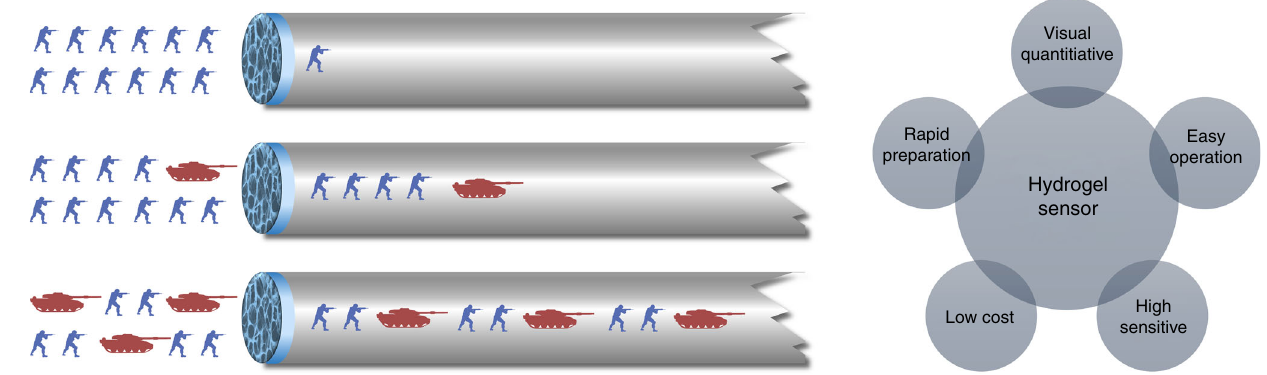
Fig. 1 The scheme of a target-responsive hydrogel fi lm in capillary tube for visual quantitative detection. The soldiers in the picture represent the solvent molecules that can slowly permeate through the gel membrane, and the tanks in the picture represent the target molecules that can degrade the gel membrane. In the presence of cocaine, cocaine molecules can change the internal structure of DNA hydrogel, resulting in an increase in the permeability of the fi lm and the fl ow rate of the solvent in the capillary. The higher the concentration of cocaine molecule is, the faster the fl ow rate